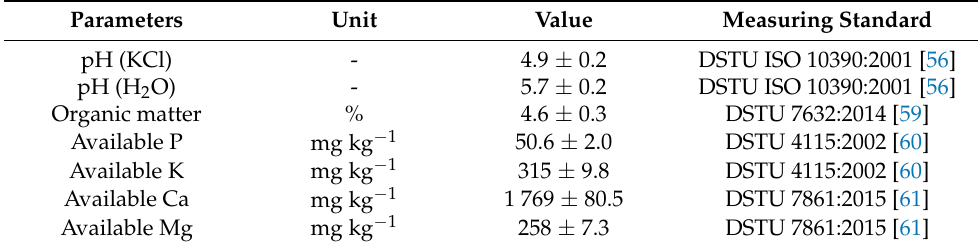
Table 3. The agrochemical parameters of the research